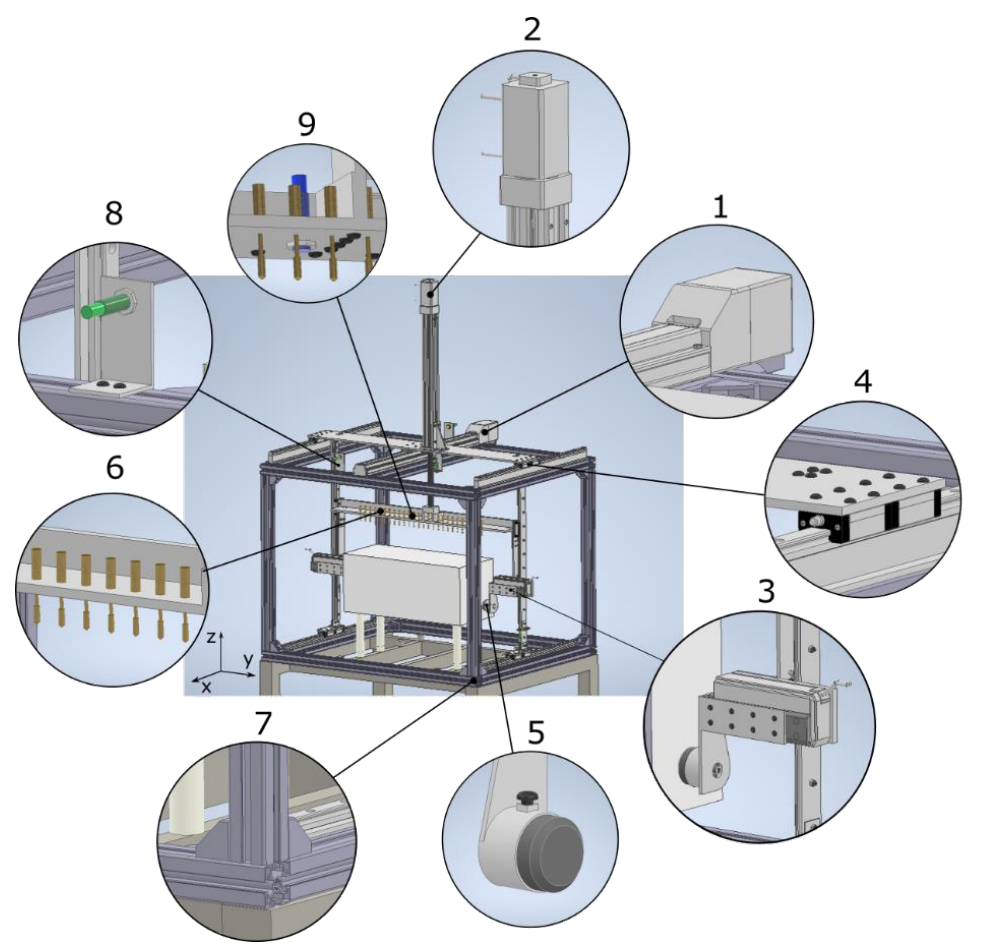
Figure 4. Proof of concept — automatic machine. 1-Linear Actuator SMC LEFS32A-700 R5CP18 [11]; 2-Linear Actuator SMC LEY32DB-450BF-R5CP18 [12]; 3-Linear Actuator SMC LES16RJ-75S-R5CP18 [13]; 4-Linear Bearing Guide MISUMI SX2RL28 [14]; 5-Ultrasonic kHz Transducer [15]; 6-Metallic Electrodes; 7-Bosch 45 × 45 Structural Profiles; 8-Inductive Digital Sensors, Telemecanique XS612B2PAL01M12 [16]; 9-Ultrasonic Digital Sensor Telemecanique XX512A1KAM8 [17].